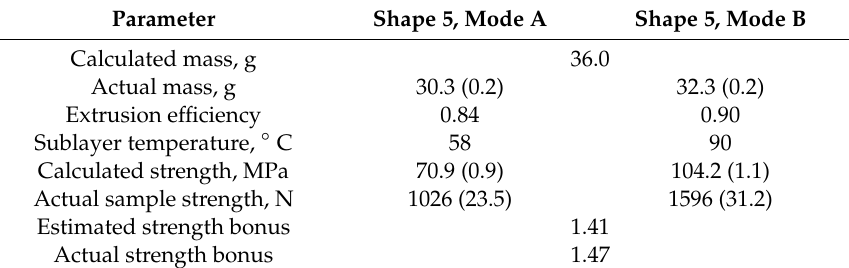
Table 6. Strengthening of Shape 5 parts by increasing of sublayer temperature and extrusion e ffi ciency (with transition from mode A to mode